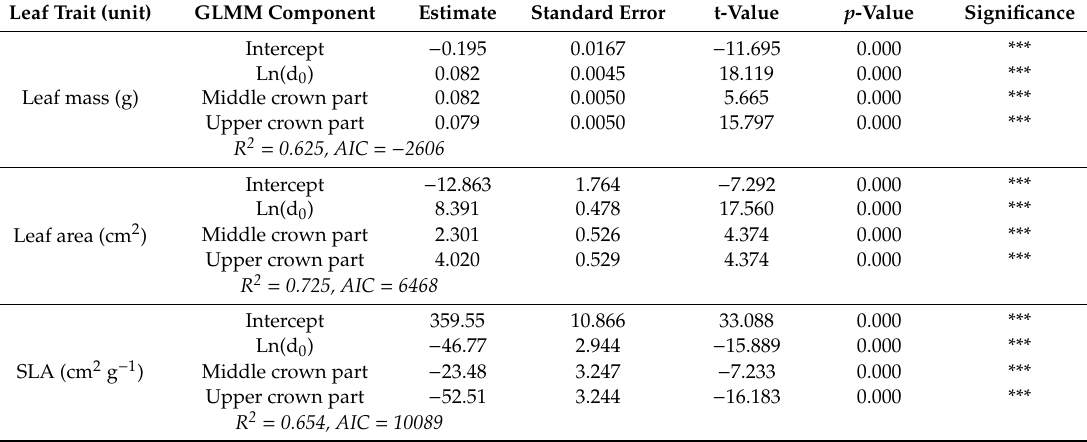
Table 5. Results of the generalised linear mixed models derived for leaf traits based on Equation (7). Leaf Trait (unit) GLMM Component Estimate Standard Error t-Value p -Value Significance